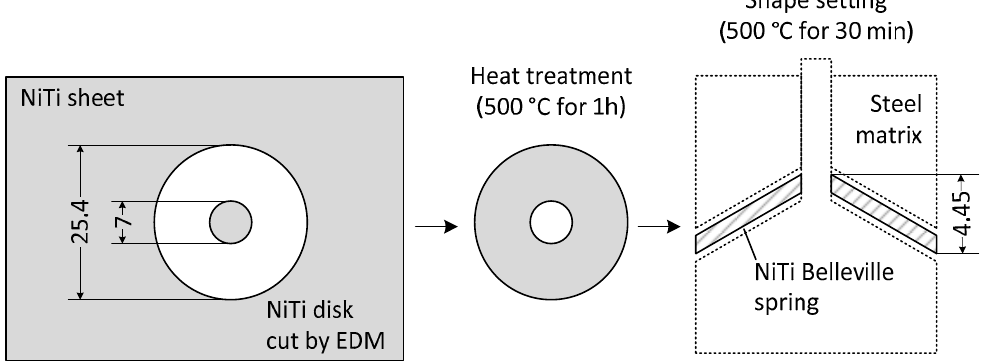
Figure 1. Fabrication process of the NiTi SMA Belleville spring. Dimensions in mm.